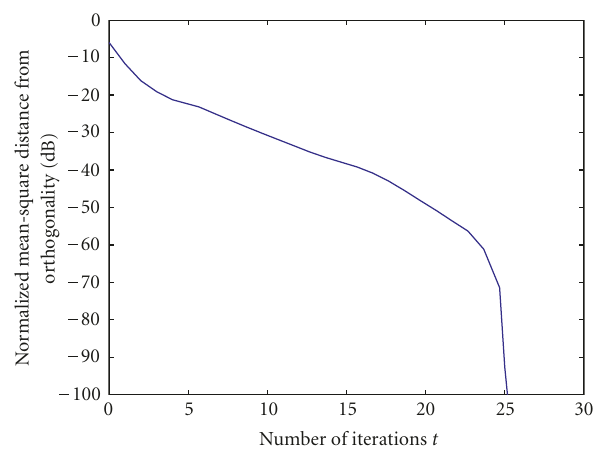
Figure 1: Evolution of E { η ( t ) } for the spatial-only unitary con- straint algorithm, m = n = 10, L = 1.